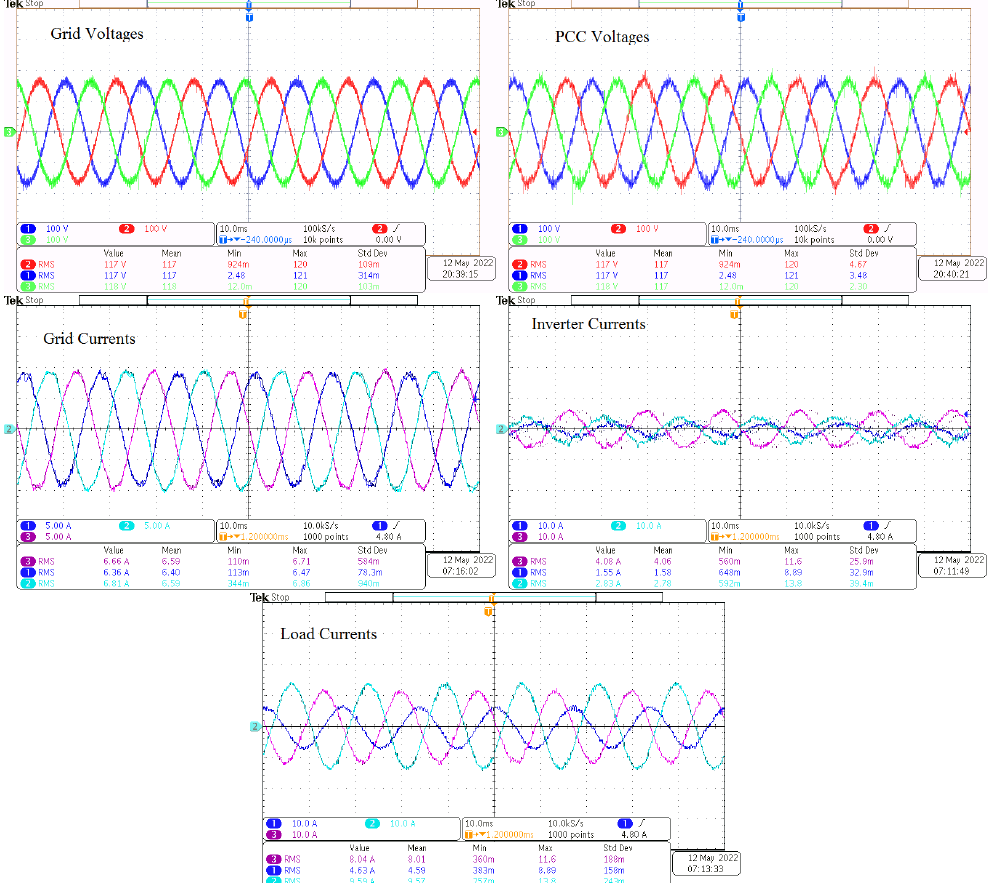
Figure 12. Experimental results when balancing the grid currents